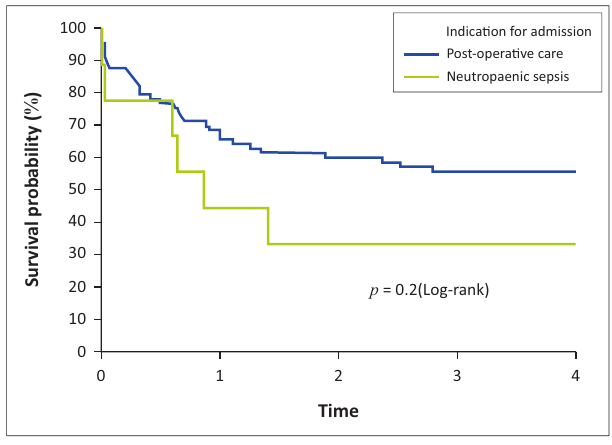
FIGURE 4: Survival probability according to indication for